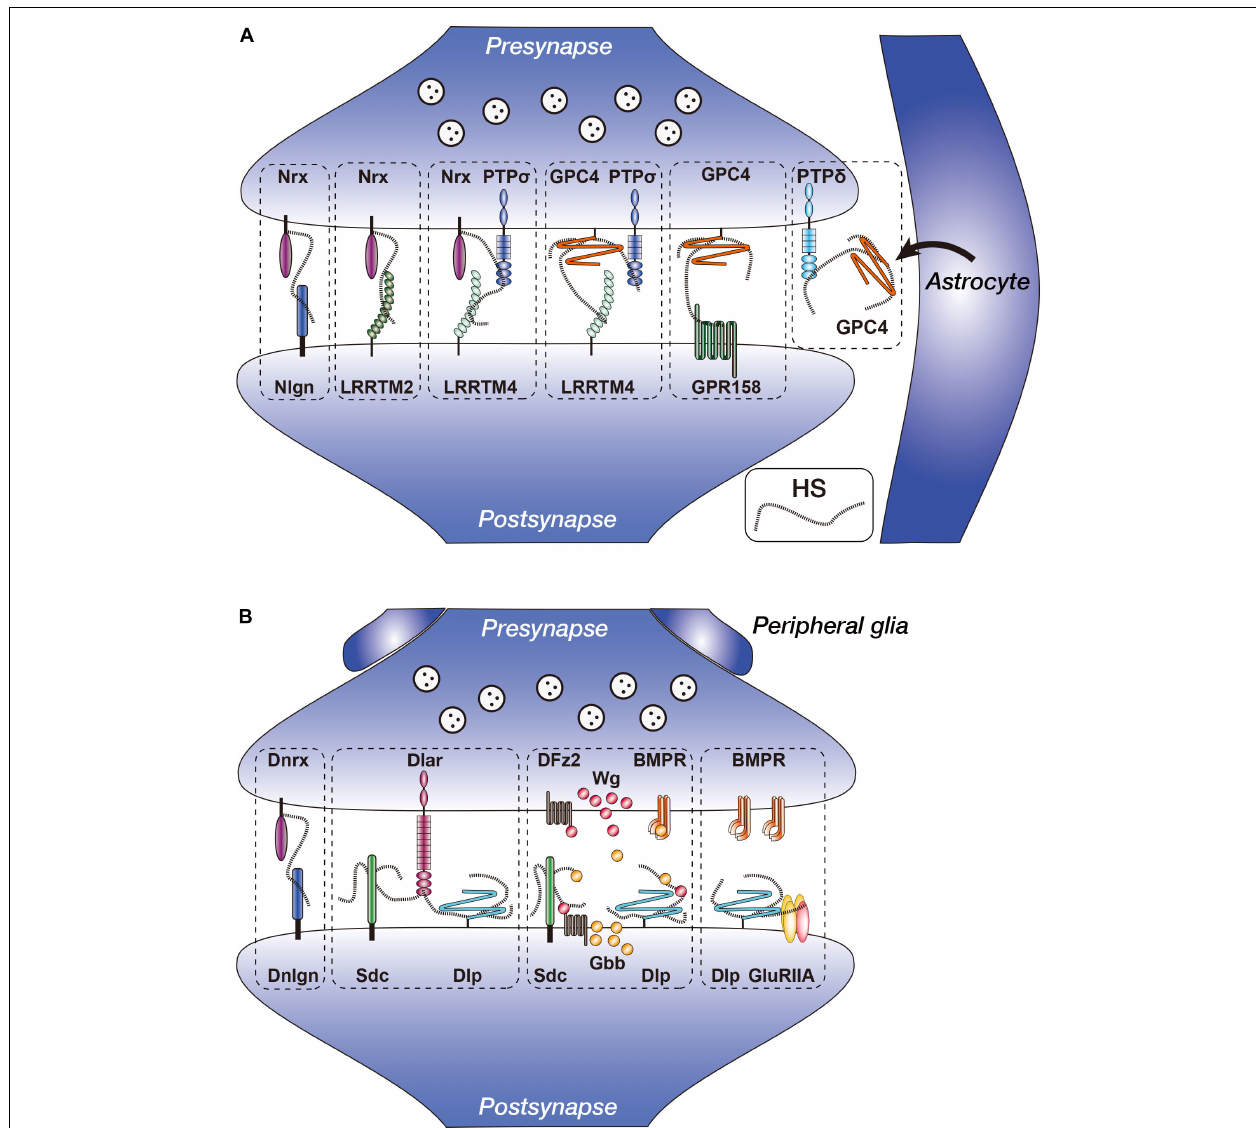
FIGURE 1 | Vertebrate and Drosophila heparan sulfate proteoglycans (HSPGs) in the synapses. (A) Heparan sulfate (HS) chains of Nrx and GPC4 interact with multiple synapse-organizing proteins. Presynaptic Nrx interacts with Nlgn, LRRTM2, LRRTM4, and PTP σ . Presynaptic GPC4 interacts with LRRTM4, PTP σ , and GPR158. Nrx–PTP σ –LRRTM4 and GPC4–PTP σ –LRRTM4 complexes reside separately at the synapses. GPC4 is secreted from astrocytes and interacts with presynaptic PTP δ . (B) Functions of Drosophila HSPGs (Dnrx, Dlp, and Sdc) in the NMJ synapses. Dnrx interacts with Dnlgn through HS chains (Zhang et al.,